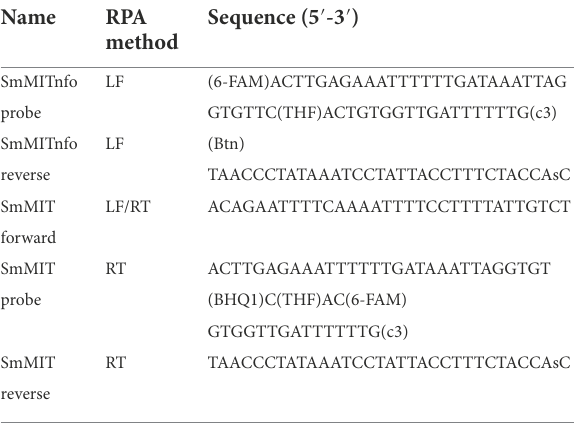
TABLE 1 Mitochondrial primer and probe sequences designed for the LF-and